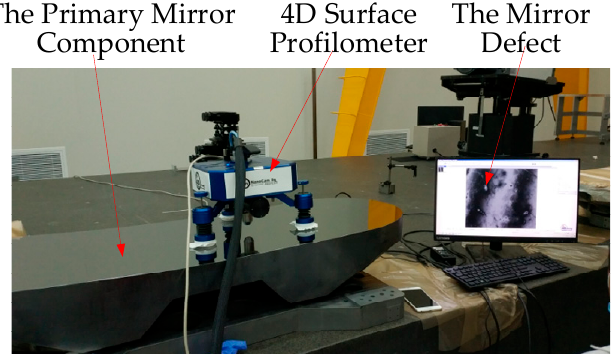
Figure 2. Primary mirror roughness detection site.